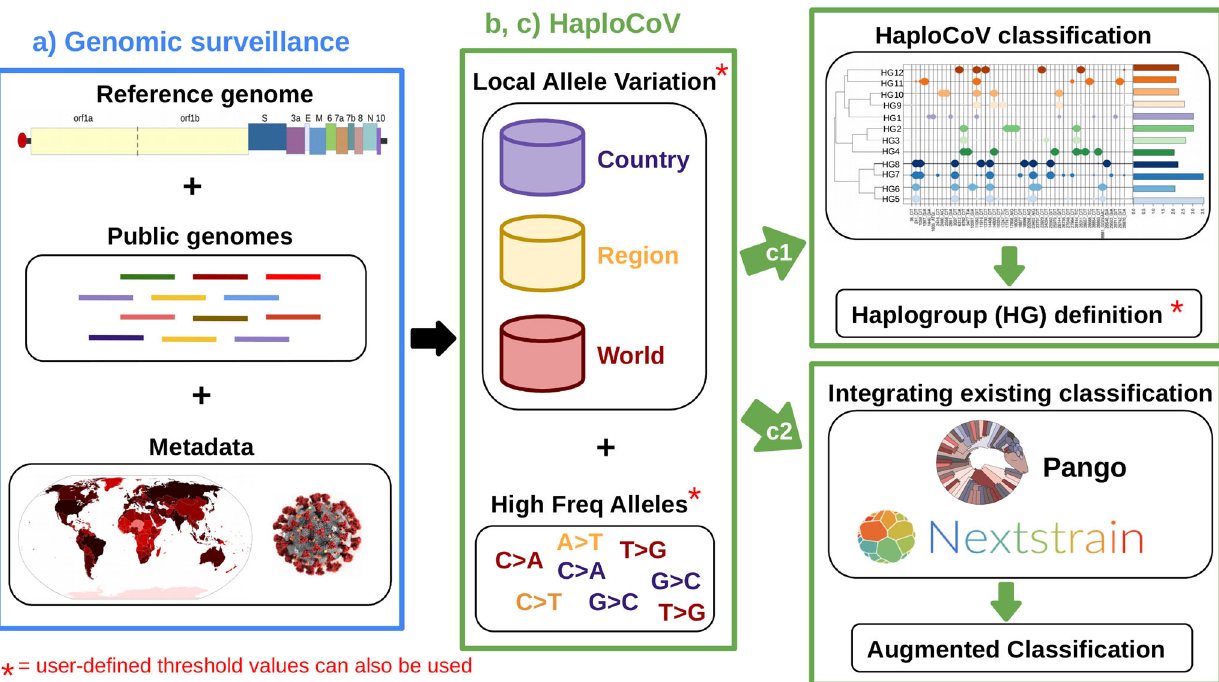
Fig. 2 Work fl ow and potential applications of HaploCoV. a SARS-CoV-2 genomic surveillance: genome sequences and associated metadata, obtained